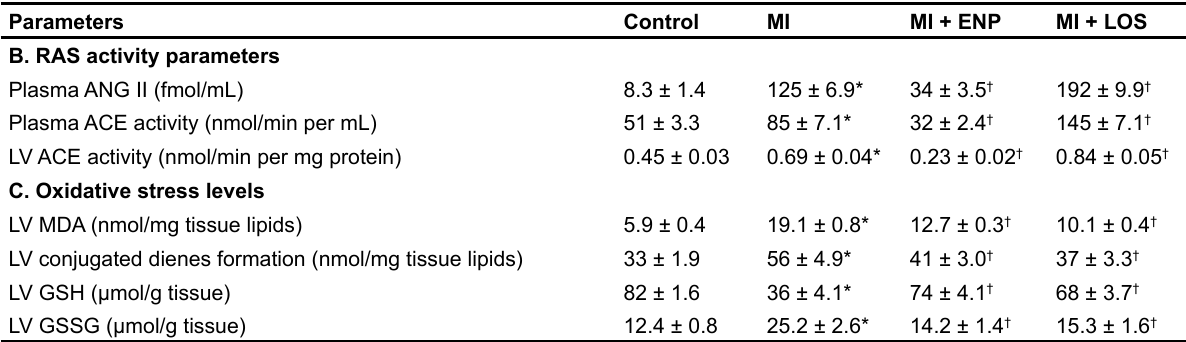
Table 1. Cardiac performance, status of RAS and oxidative stress in control and MI animals with or without ENP and LOS treatments for 4 weeks starting at 3 weeks after induction of MI ( continued )